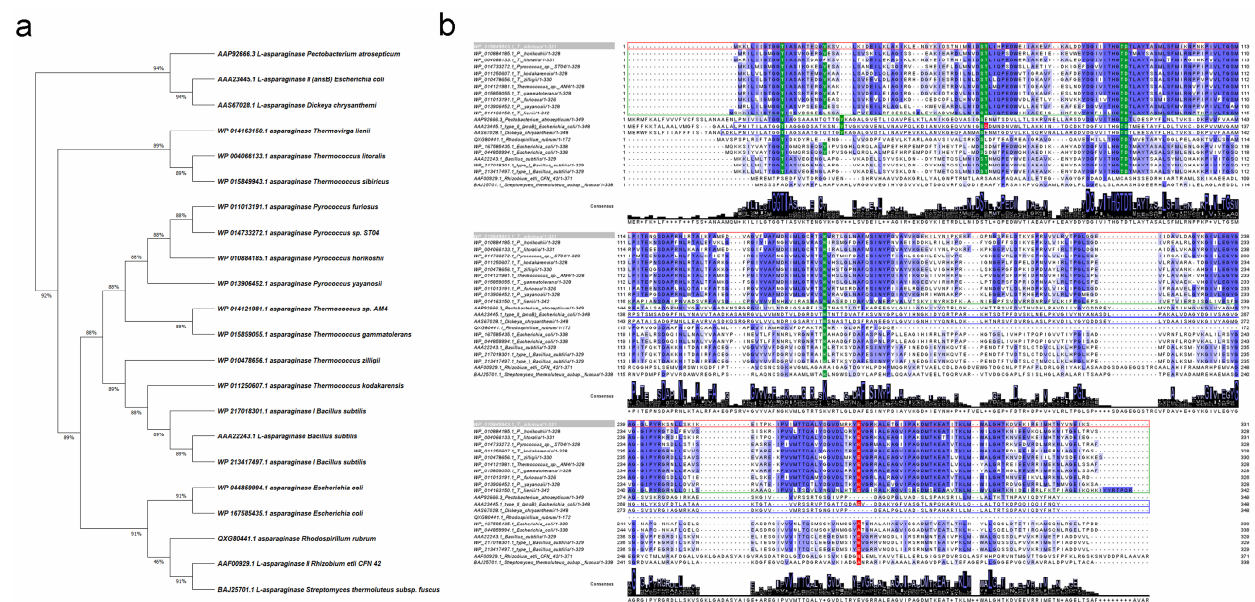
Figure 1. Comparison of L-asparaginase (L-ASNase) from T. sibiricus (TsA) with selected L-ASNases of thermophilic and mesophilic origin. ( a ) Molecular phylogenetic analysis of selected L-ASNases by maximum likelihood method. The analysis involved 22 amino acid sequences. There were a total of 371 positions in the final dataset. Evolutionary analyses were conducted in MEGA X [60]. ( b ) Amino acid sequence comparison of L-ASNase T. sibiricus (WP_015849943, marked with red box) with its homologs from thermophiles P. horikoshii (WP_010884185), T. litoralis (WP_004066133), Pyrococcus sp. ST04 (WP_014733272), T. kodakarensis (WP_011250607), T. zilligii (WP_010478656), Thermococcus sp. AM4 (WP_014121981), T. gammatolerans (WP_015859055), P. furiosus (WP_011013191), P. yayanosii (WP_013906452), T. lienii (WP_014163150) and Streptomyces thermoluteus subsp. fuscus (BAJ25701.1) and mesophiles P. atrosepticum (AAP92666.3), E. coli (type II— AAA23445.1, type I—WP_044859994.1, WP_167585435.1), D. chrysanthemi (AAS67028.1), Bacillus subtilis (AAA22243.1, type I—WP_217018301.1, WP_213417497.1), R. rubrum (QXG80441.1) and Rhizobium etli CFN 42 (AAF00929.1). Identical amino acid residues are marked by blue, strongly conserved residues crucial for the catalytic activity of selected L-ASNases are indicated by green, observed key substitutions are marked by red. Amino acid sequences of hyperthermophiles are marked in green boxes; FDA-approved L-ASNases (in processed form) are marked in blue boxes. Multiple sequence alignments were carried out using Clustal version 2.1 [61].